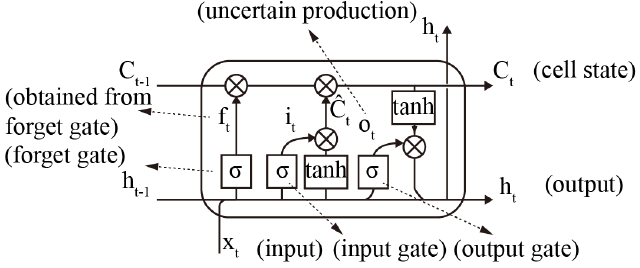
Figure 2. Detailed flow diagram of the LSTM network structure.